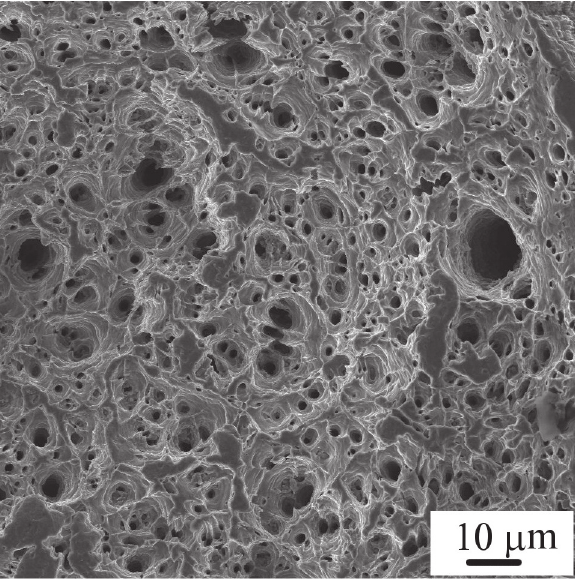
Figure 4. Fracture surface of Al-4Al 4 C 3 material (strain rate 10 (cid:3) 3 s (cid:3) 1 , temperature 573